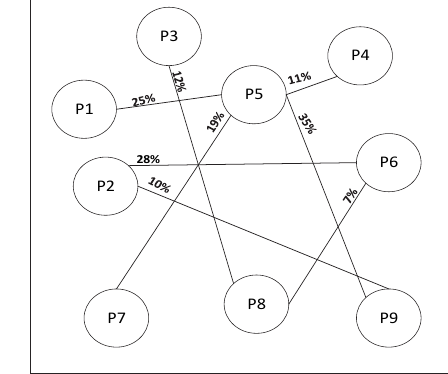
Fig. 6. Resource interdependencies network Fig. 7. Technology and knowledge interdependency net- work